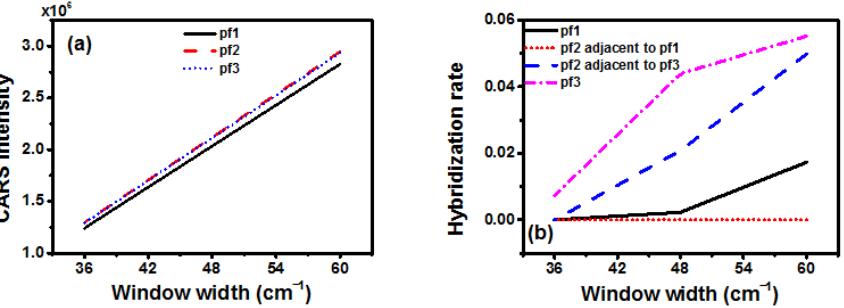
Figure A2. ( a ) Influences of window width w on CARS intensity, and ( b ) on hybridization rate.